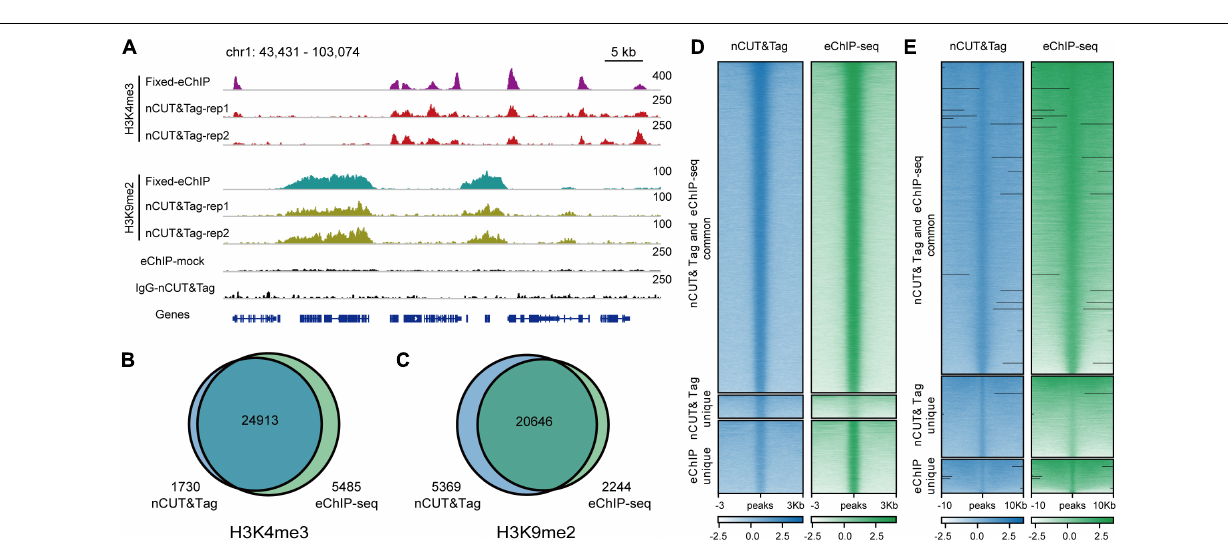
FIGURE 4 | nCUT&Tag for chromatin landscape profiling with non-crosslinked tissue. (A) Genome browser screenshot showing H3K4me3 and H3K9me2 nCUT&Tag data for fresh rice seedlings. The H3K4me3 and H3K9me2 eChIP-seq data were generated with crosslinked seedlings. (B) Venn diagram showing the overlap of H3K4me3 peaks detected by fresh nCUT&Tag and crosslinked eChIP-seq. (C) Venn diagram showing the overlap of H3K9me2 peaks detected by fresh nCUT&Tag and crosslinked eChIP-seq. Comparison of nCUT&Tag and eChIP-seq signals for H3K4me3 (D) and H3K9me2 (E)